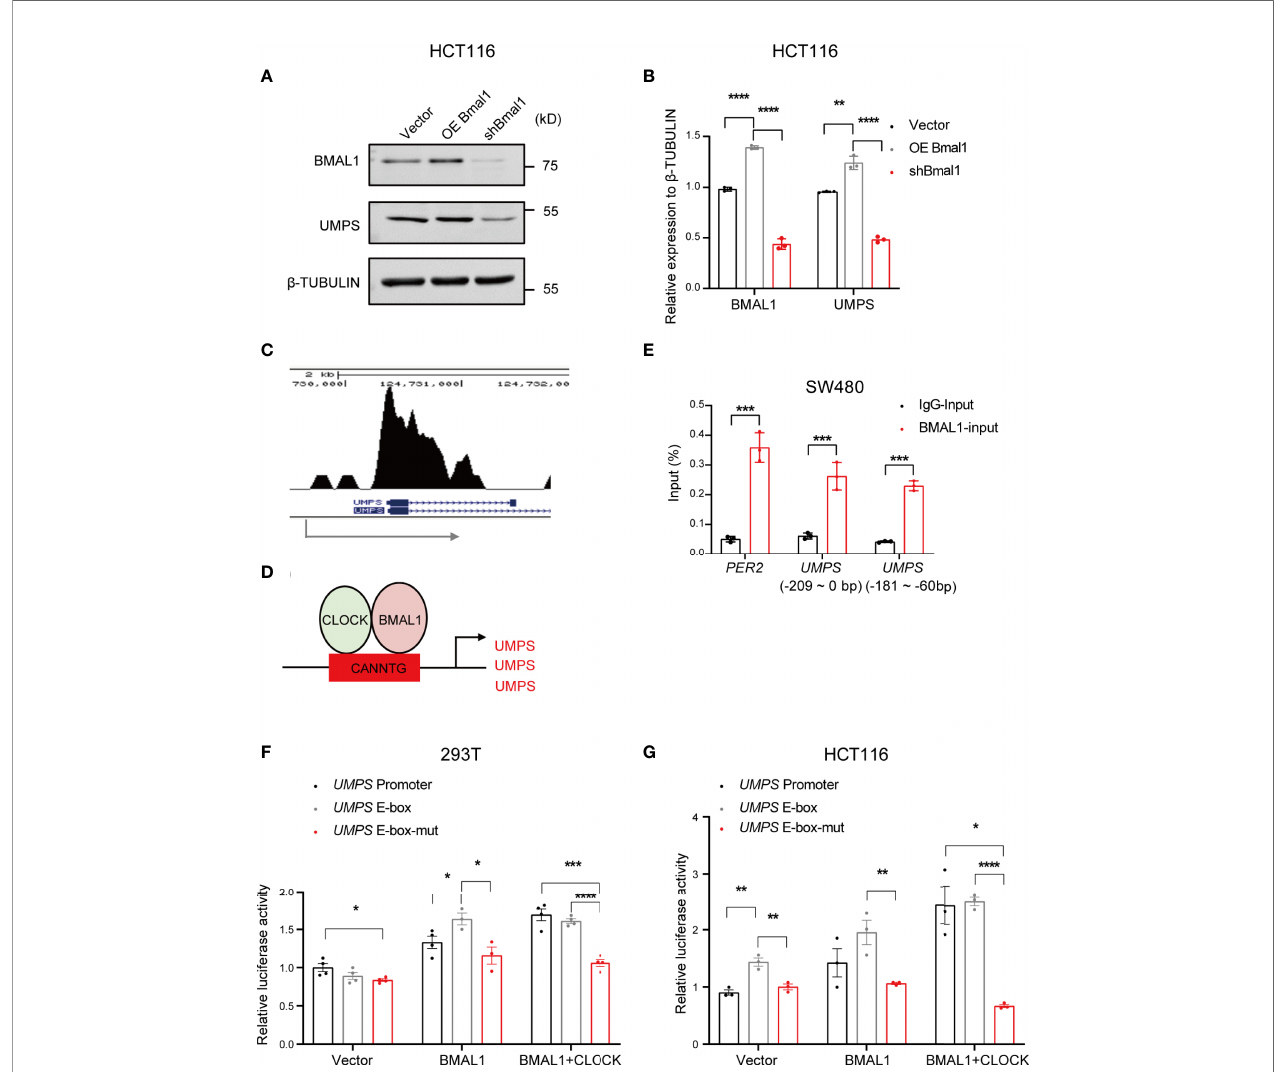
FIGURE 5 | BMAL1 regulates UMPS expression by binding to the E-box in the UMPS promoter. (A, B) The protein expression levels of BMAL1 and UMPS upon knockdown or overexpression of BMAL1 in HCT116 cells via western blotting. (C) ChIP-seq of BMAL1 showed binding signals on the promoter region of UMPS in CRC LOVO cells. The blue arrow indicates the transcription start site (TSS) of the UMPS gene. (D) The schematic shows the CLOCK-BMAL1 binding sites at the UMPS promoter. (E) ChIP analysis of BMAL1 binding to the E-box region of UMPS in HCT116 cells. -186 bp represents 186 base pairs from the transcriptional start site of UMPS . (F, G) Luciferase reporter assays revealed transcriptional activation of UMPS in HEK 293 and HCT116 cells by BMAL1 or BMAL1+CLOCK. When the binding site was mutated, the activation was signi fi cantly decreased. * indicates p < 0.05, ** indicates p < 0.01, *** indicates p < 0.005, **** indicates